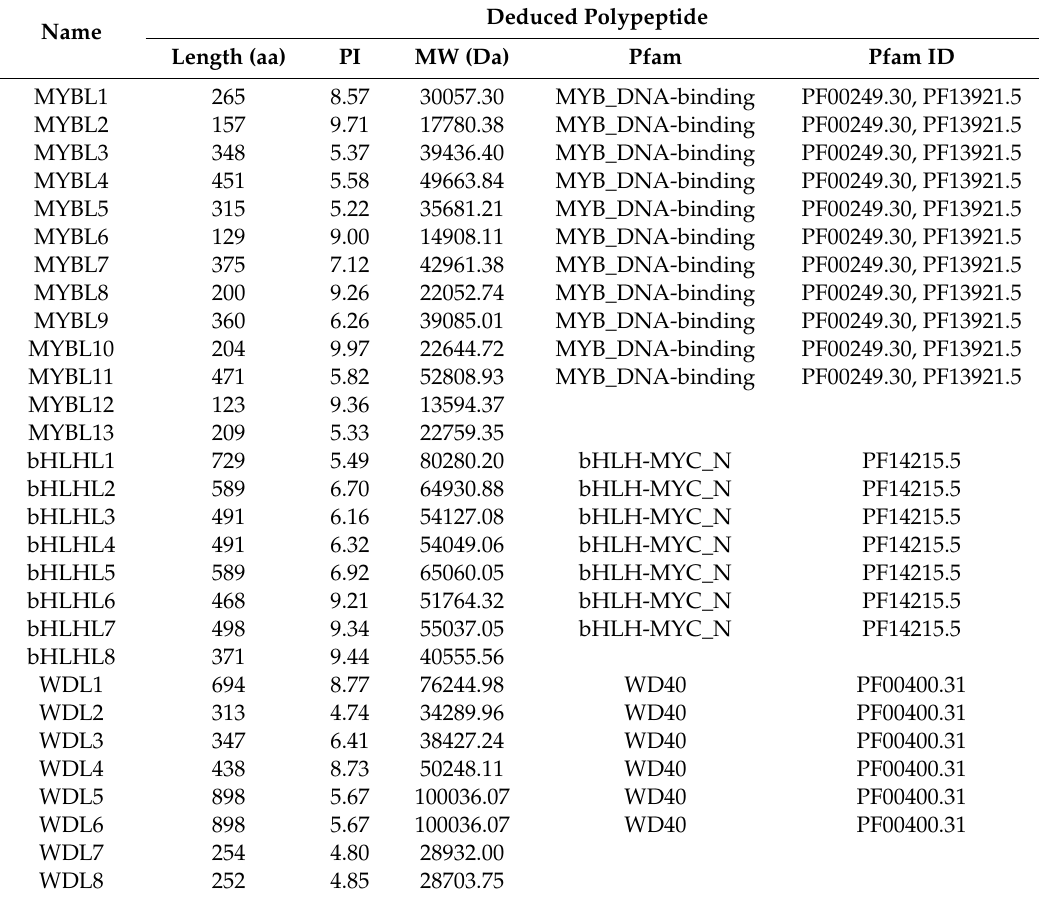
Table 1. Homologous MYB-bHLH-WD40 complex gene family members in blueberry